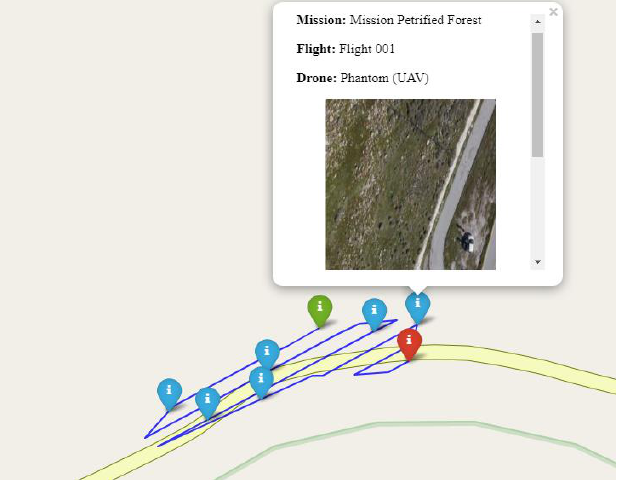
Figure 1. Drone’s flight area of interest in the presented scenario, taking photos (blue pins) during a cultural heritage documentation mission (green and red pins represent the start and the end of the